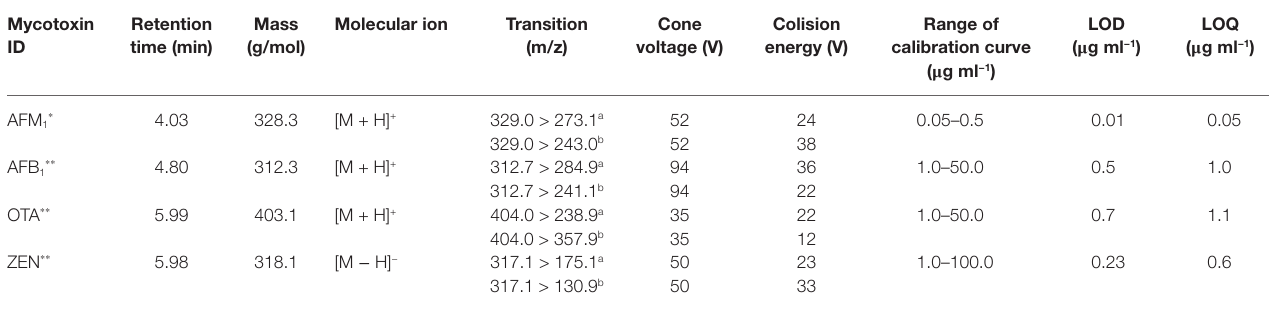
a Transitions used for quantification. b Transitions used for